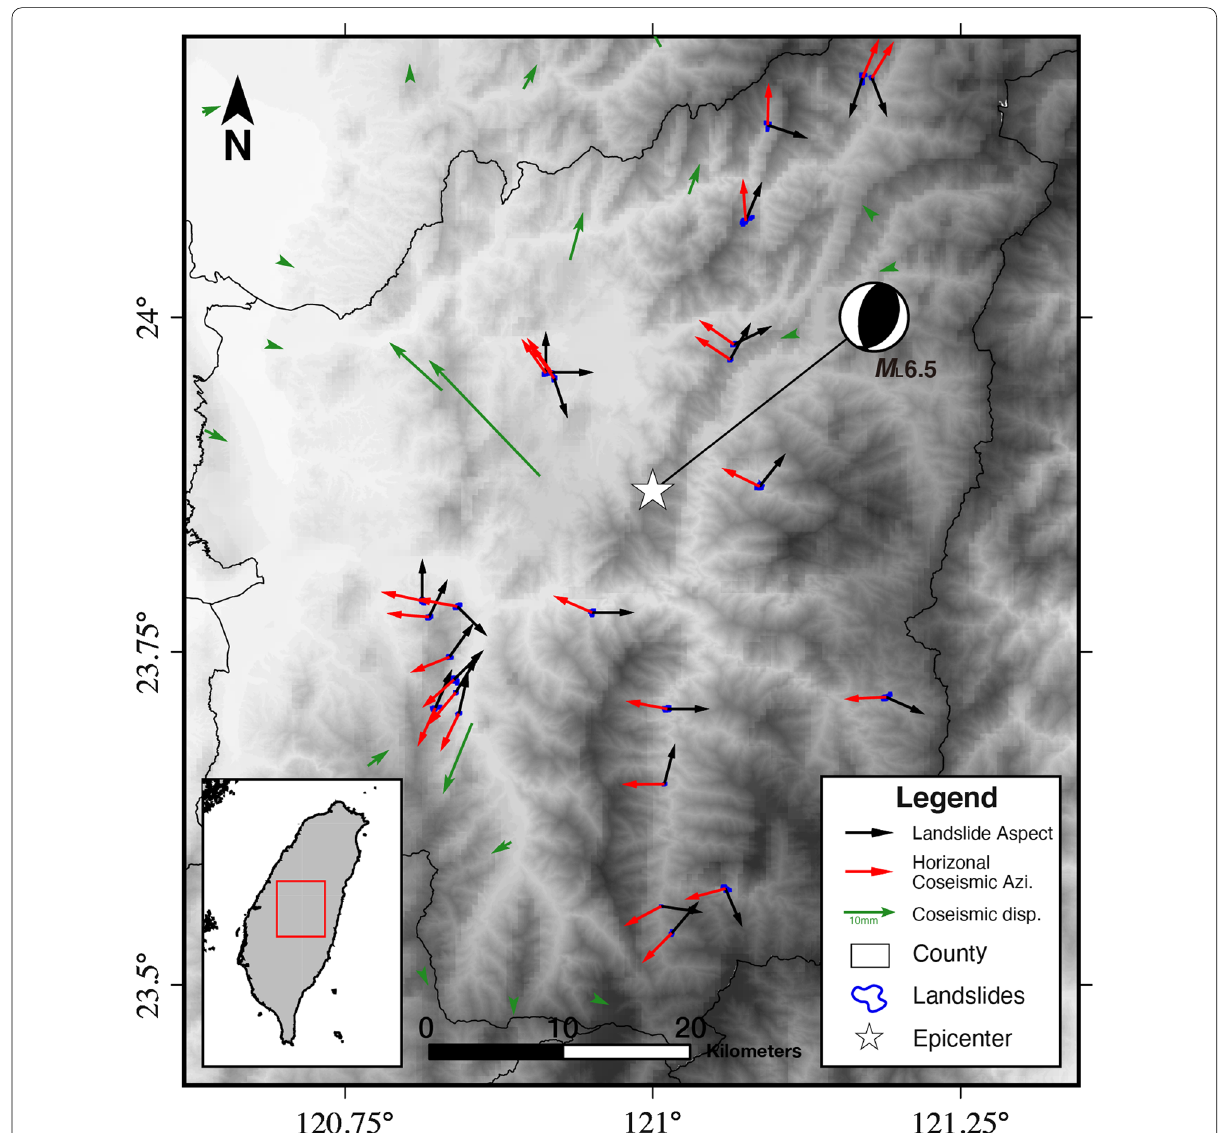
Fig. 4 Comparison between landslide aspects (black arrows) and the azimuths of horizontal coseismic displacement (red arrows) for the landslides induced by the 2013 M L 6.5 Nantou earthquake. White star denotes the epicenter. Small blue polygons are earthquake‑triggered landslides. Black arrows are landslide aspects, red arrows are surface displacements at landslides, green arrows are observed coseismic